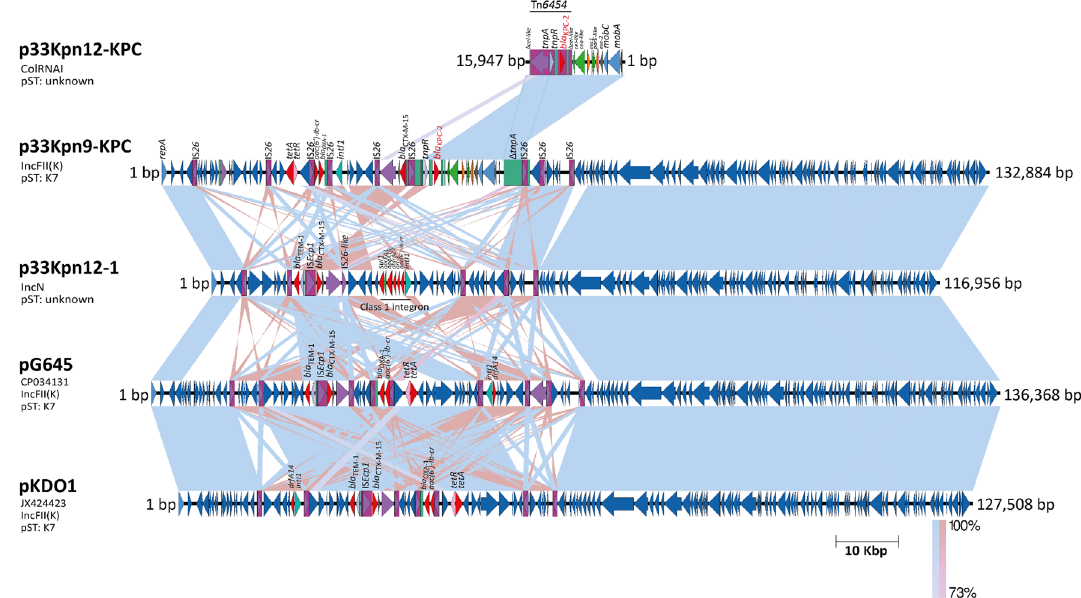
Figure 5. Comparison of the plasmids determined in the K. pneumoniae 33Kpn9 and 33Kpn12 isolates with the IncFII (K) plasmids previously reported. The sequences p33Kpn9-KPC (CP064297), p33Kpn12-1 (CP062793) and p33Kpn12-KPC (CP062794) were compared using a BLAST Pairwise Alignment with Nucleotide database, pG645 (CP034131) of K. quasipneumoniae and pKDO1 (JX424423) of K. pneumoniae were the plasmids with more identity percent. The shaded area between the sequences delimits the alignment regions with a percentage of identity ≥ 73%. The blue arrows indicate the open reading frames and, adjacent to the gene of interest, the coding regions for hypothetical proteins (gray), transposases (purple), resolvases (purple), resistance genes (red) are highlighted and delimited by a purple rectangle to transposons. The duplication sites (TSDs) generated by the transposition were illustrated and delimited in dotted lines for each mobile genetic element. The graph has a scale line of 10,000